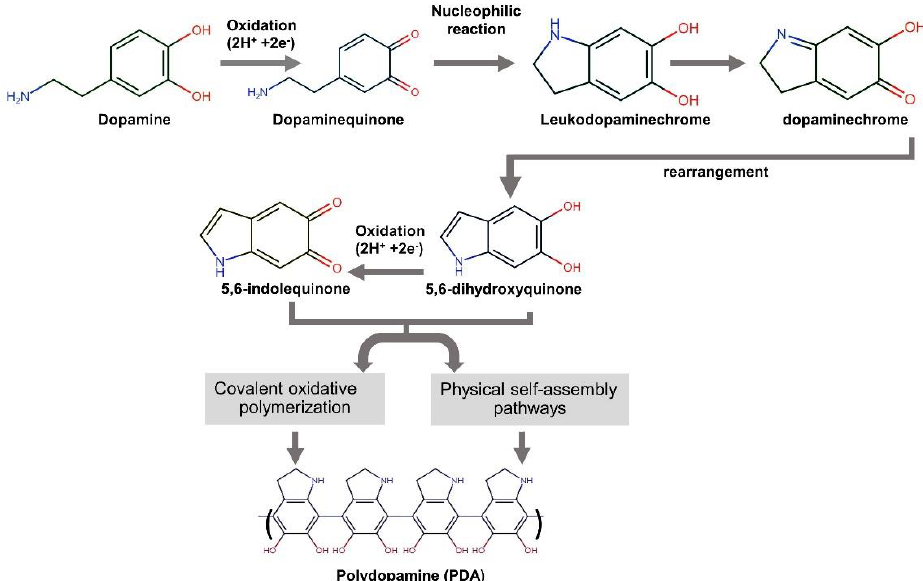
Figure 1. A schematic illustration of the reaction mechanism of polydopamine formation from dopamine [21,26,27].